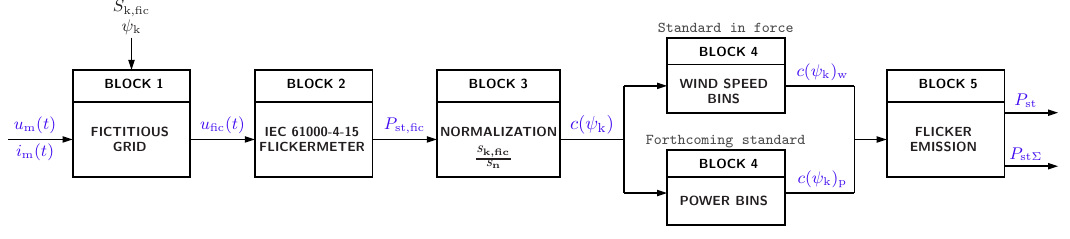
Figure 1. Block diagram of the measurement and assessment procedure for flicker during continuous operation of a grid connected WT according to the IEC 61400-21 standard in force and its